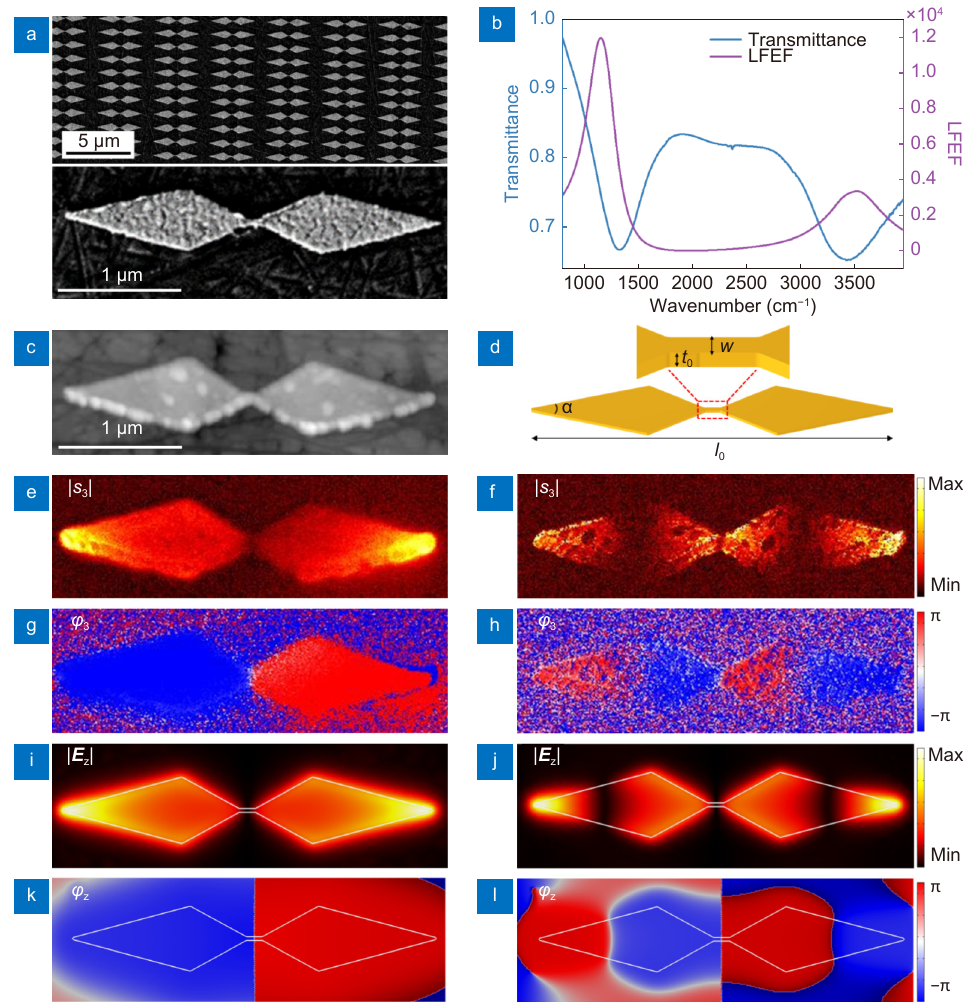
Fig. 1 | ( a ) Scanning electron microscopy (SEM) image of NBRA structures. ( b ) Experimental transmittance of the NBRA array (blue curve) and simulated LFEF at the extremities of the structure (purple curve). ( c ) AFM topography of a single NBRA structure. The scale bars are 1 μm. ( d ) Sketch and parameters of the NBRA structure, consisting of two rhombic arms connected with each other by a nanobridge. The thickness ( t 0 ) and total length ( l 0 ) of NBRA are 30 nm and 2800 nm. The nanobridge is 30 nm in width and 130 nm in length. The radius of sharp tip of each arm is 10 nm and α is 30°. ( e – h ) Measured near-field (e, f) amplitude and (g, h) phase of single NBRA structure at 1100 cm −1 and 2100 cm −1 , re- spectively. ( i – l ) Simulated | E z | (i, j) and φ z (k, l) of single NBRA structure at 1100 cm −1 and 2100 cm −1 ,